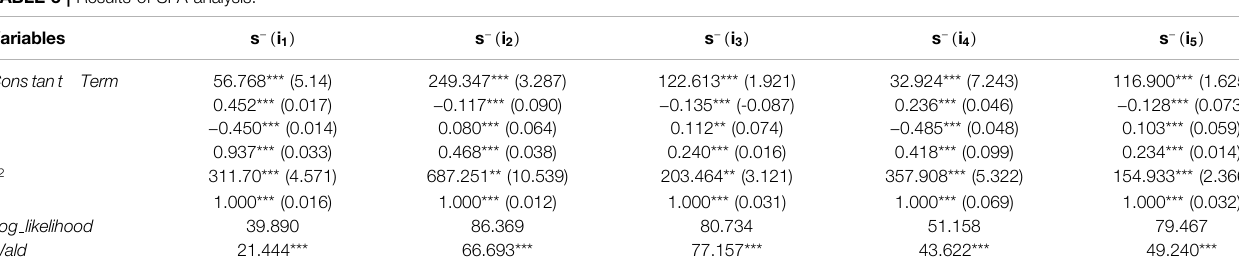
TABLE 3 | Results of SFA